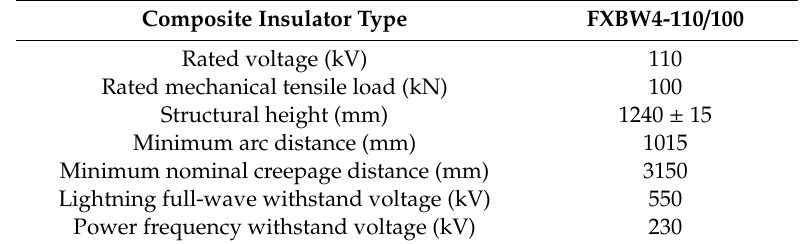
Table 3. Characteristics of conductors and ground